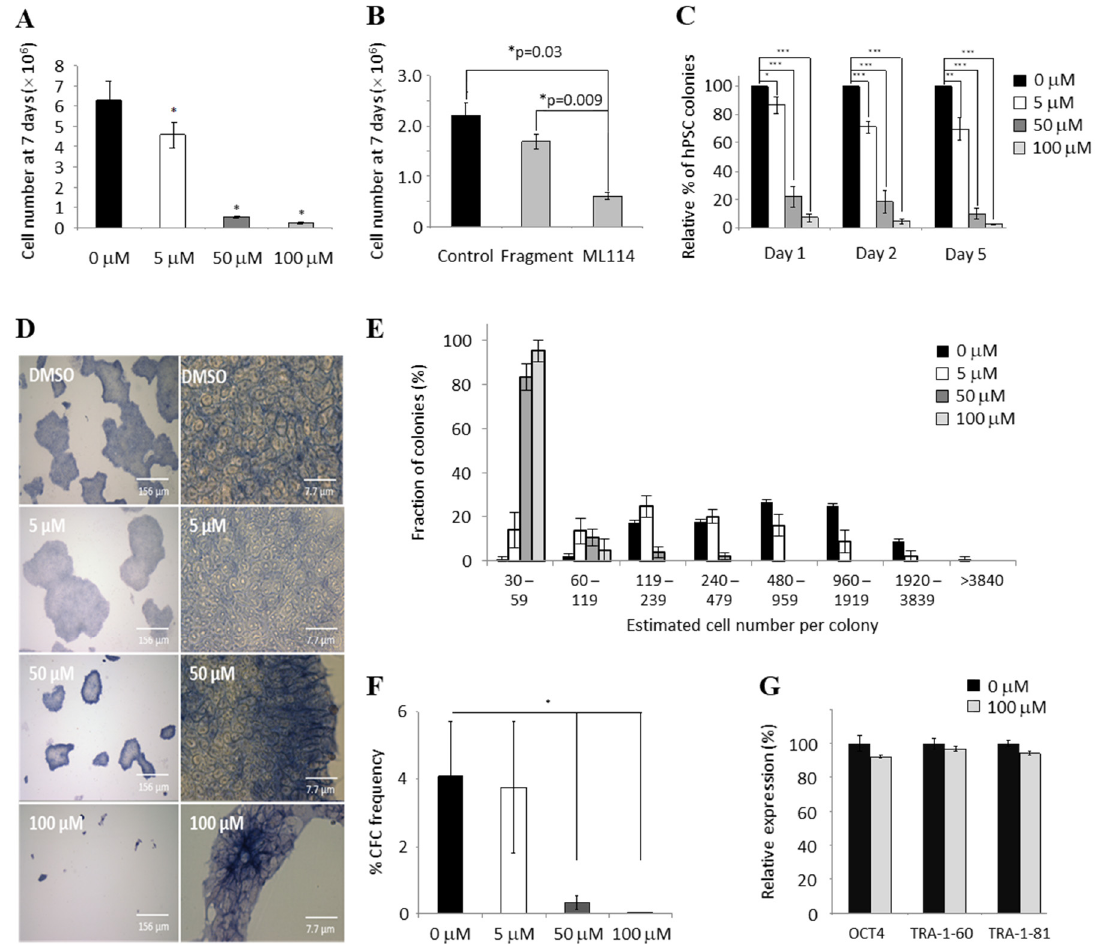
Figure 1. ML114 reduces hPSC growth rate without reducing pluripotency markers. ( A ) Dose